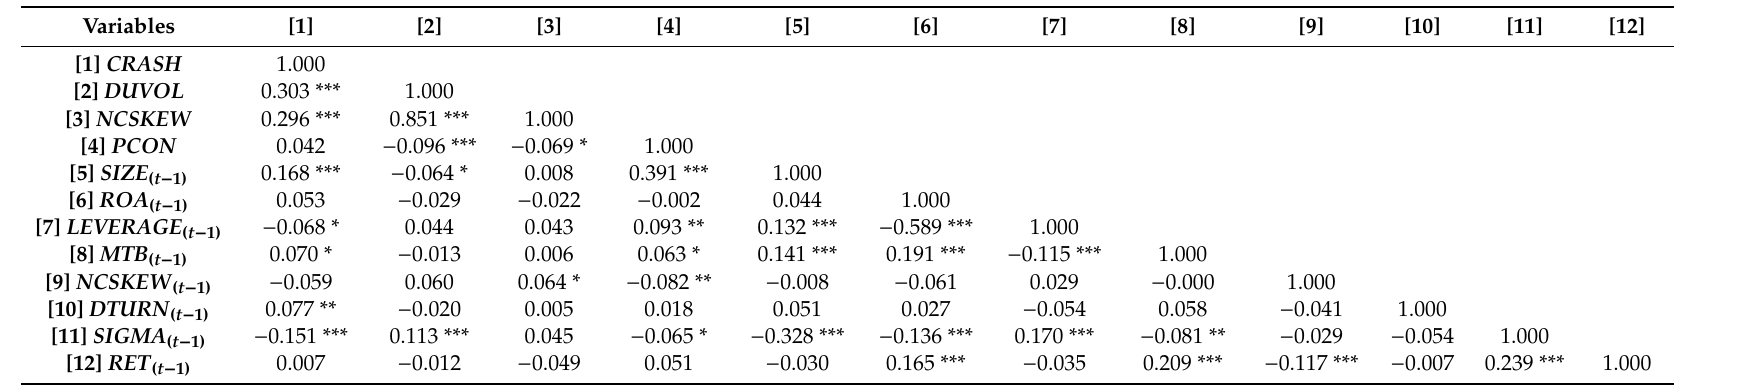
Table 3. Pearson correlations (n =